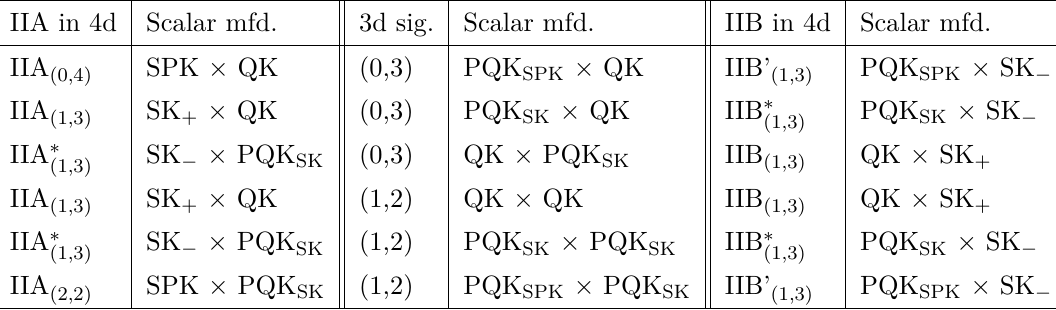
Table 13 . Summary of T-dualities between type-IIA and type-IIB Calabi-Yau compactifications for all (inequivalent) four-dimensional signatures. In the middle we specify the three-dimensional theory to which the T-dual four-dimensional theories